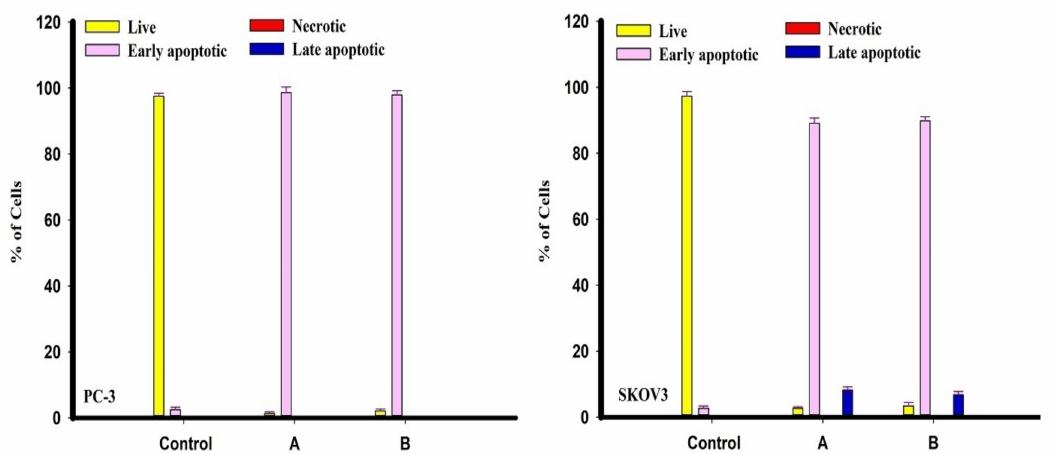
Figure 4. Percentage of apoptotic PC-3 (left) and SKOV3 (right) tumor cells after 48 h treatment with compounds A ( 1 ) and B ( 2 ) (mean ± SD of three independent experiments in three repeats each) compared to control